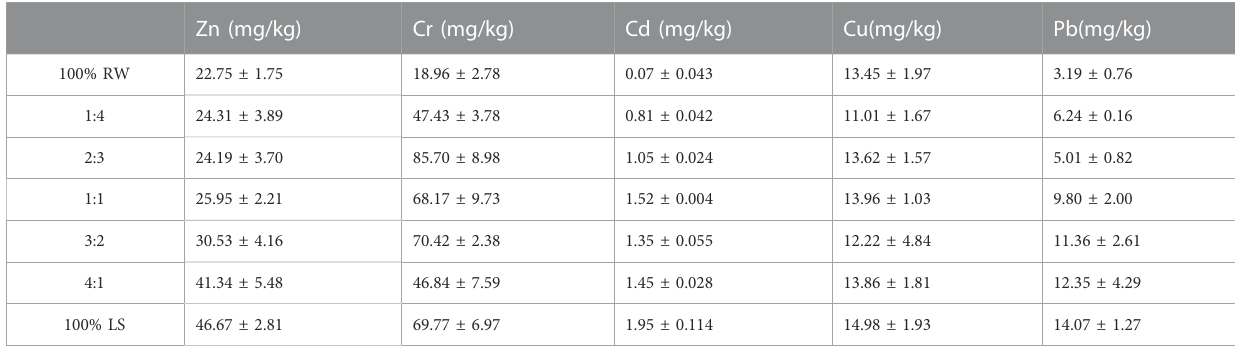
TABLE 3 Typical heavy metal contents in conversion